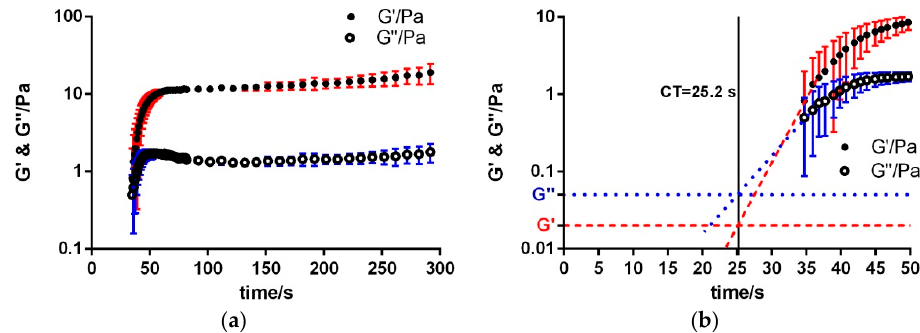
Figure 1. The oscillatory rheometer reliably determines the prothrombin time (PT) of citrated blood activated with Thromborel. ( a ) Mean elastic and viscous shear moduli of citrated blood activated with Thromborel ( n = 10 ± SD) are shown over time. The measurement was performed at a shear stress of 0.04 Pa with 1 Hz and a 1°/40 mm stainless steel cone geometry; ( b ) Enlarged part from diagram ( a ). The dashed red line at 0.02 Pa visualises the elastic shear modulus and the dotted blue line at 0.05 Pa the viscous shear modulus of uncoagulated citrated blood with no coagulation activator. After the addition of the activator Thromborel an increase of G ′ and G ″ was observed. The black solid line is the clotting time (CT = 25.2 s).